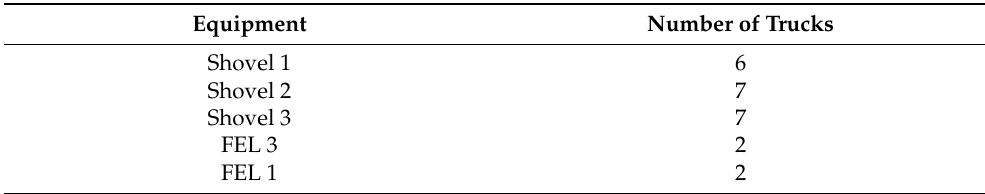
Table 7. Truck distribution for each piece of loading equipment.